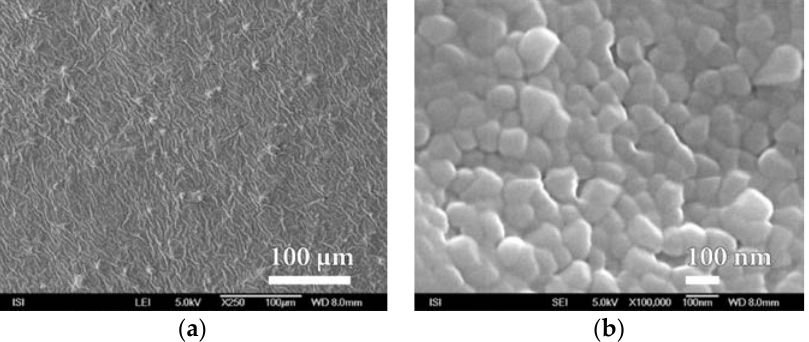
Figure 10. SEM micrographs of the surface SiO x barrier nanocoating prepared by plasma deposition with the PVD method on PVDC foil laminated on the PEVA foil, at magnification of ( a ) 1000× and ( b ) 80,000×. Figure 11. SEM micrographs of melamine nanocoating surface on PEVA SiO x foil prepared by PVD plasma deposition method at magnification of ( a ) 250 × and ( b ) 100,000 ×